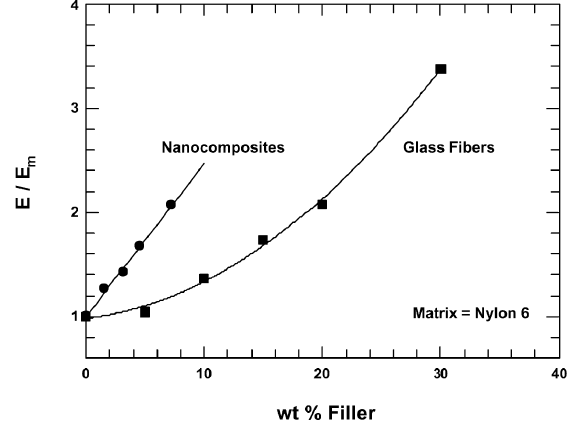
Figure 7. Comparison of modulus reinforcement (relative to matrix polymer) for nanocomposites based on montmorillonite (MMT) versus glass fibre for a PA 6 matrix [141].